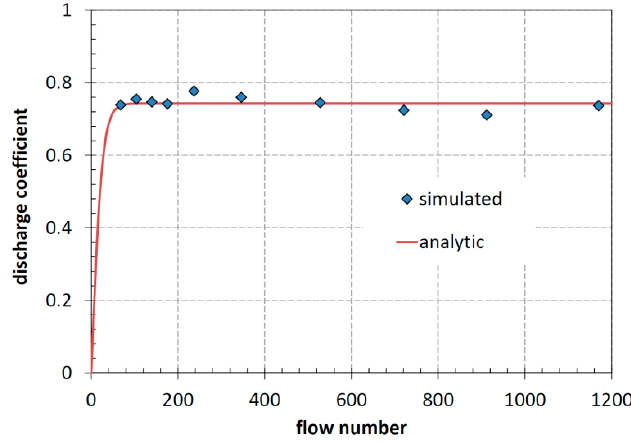
Figure 12. Discharge coefficient vs. flow number: tuning of analytic model on CFD results.